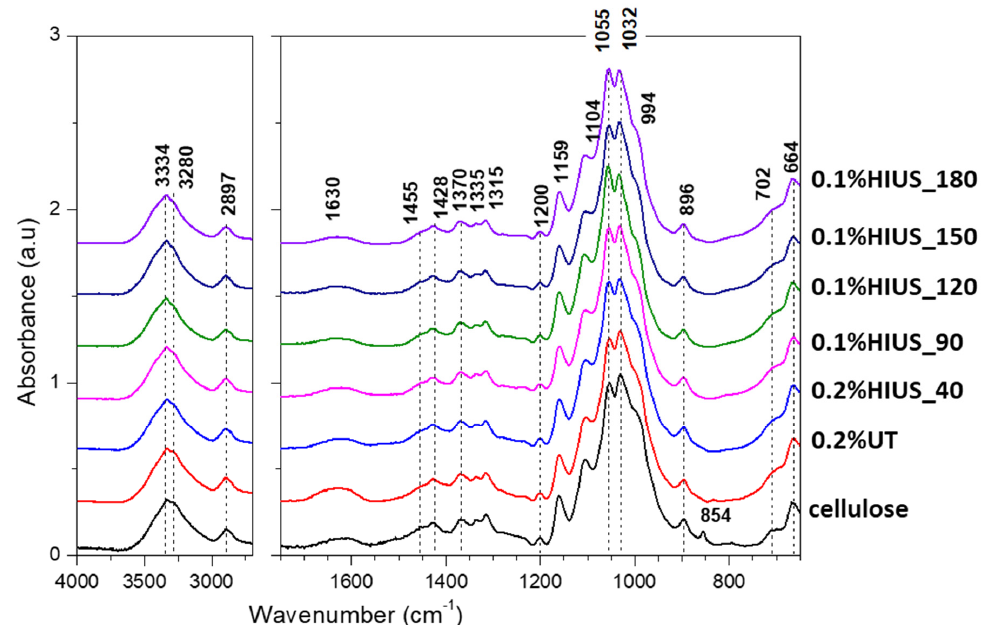
Figure 5. FTIR spectra of cellulose isolated from hop stems before and after HIUS treatment are presented in the range of 4000–2900 cm − 1 and 1750–650 cm − 1 . The most characteristic bands are highlighted on spectra with dashed line.